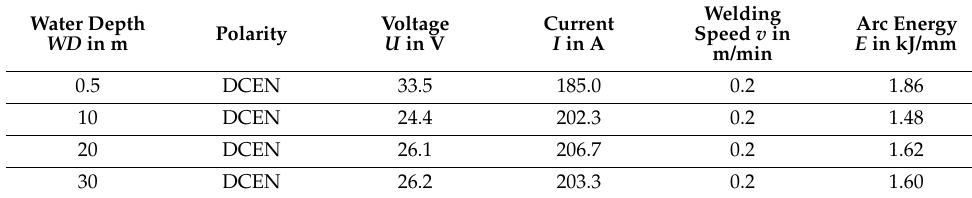
Table 1. Welding parameters (mean values of measured process parameters).